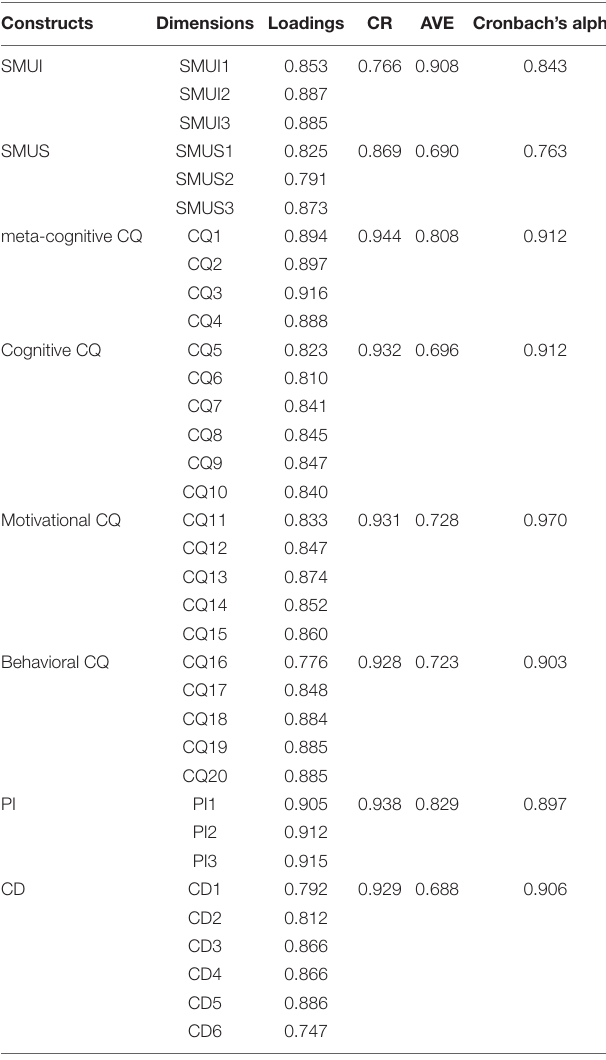
TABLE 2 | Means, standard deviations, and correlation matrix ( N = 2058). TABLE 3 | Measurement of